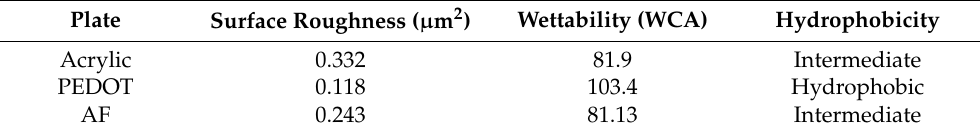
Table 1. Results of the analysis of surface roughness and wettability of the two materials (Acrylic, PEDOT) and antifouling (AF) paint. WCA = Water Contact Angle; High = WCA > 90 ◦ ; Intermediate = 45 ◦ < WCA < 90 ◦ .